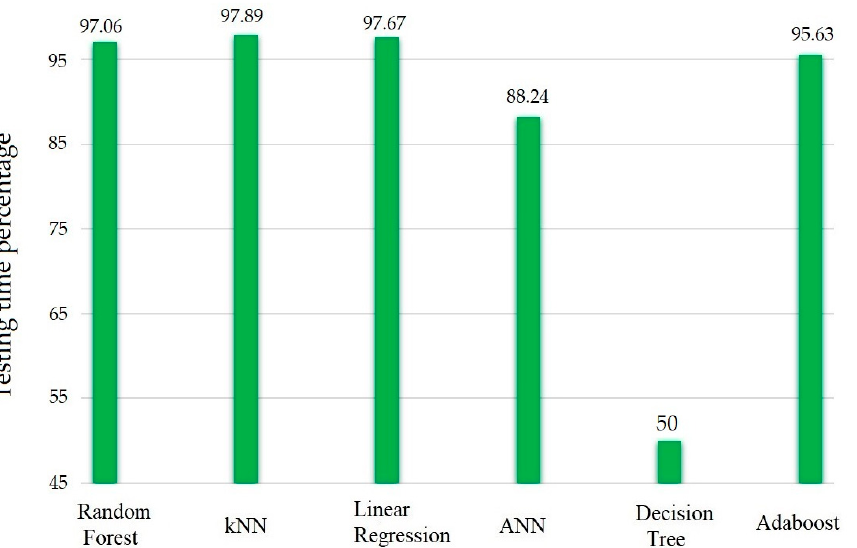
Figure 11. Comparison of the predictive algorithms training times required on a percentage basis using the hybrid model (modified data set).